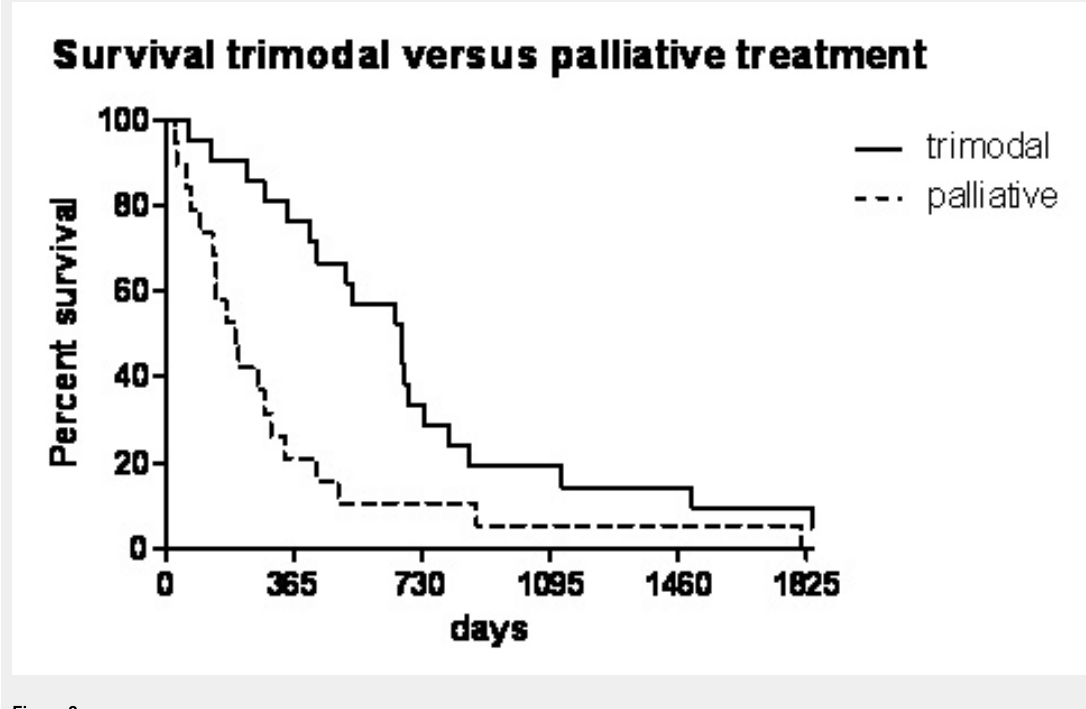
Figure 2 Long-term survival analysis by Kaplan-Meier survival curve of trimodal versus palliative